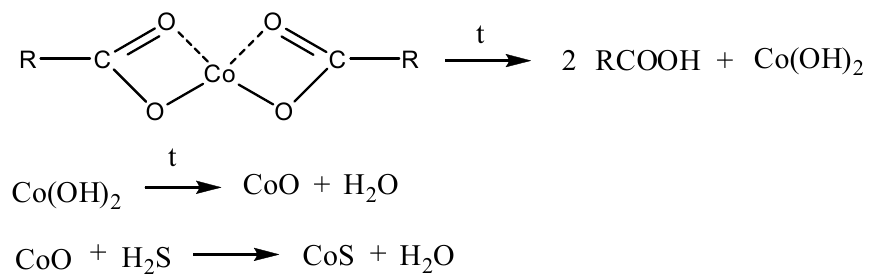
Figure 1. Fractional composition of oil resins from Ashalcha field.